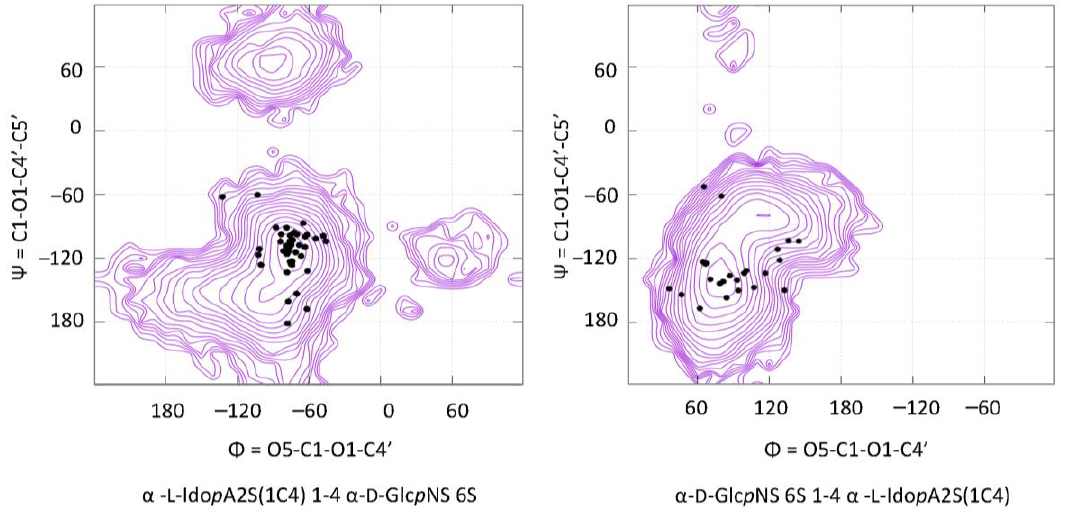
Figure 7. Φ and Ψ angles measured in the 3D structures of cocrystallized GAG protein complexes, reported on conformational maps.